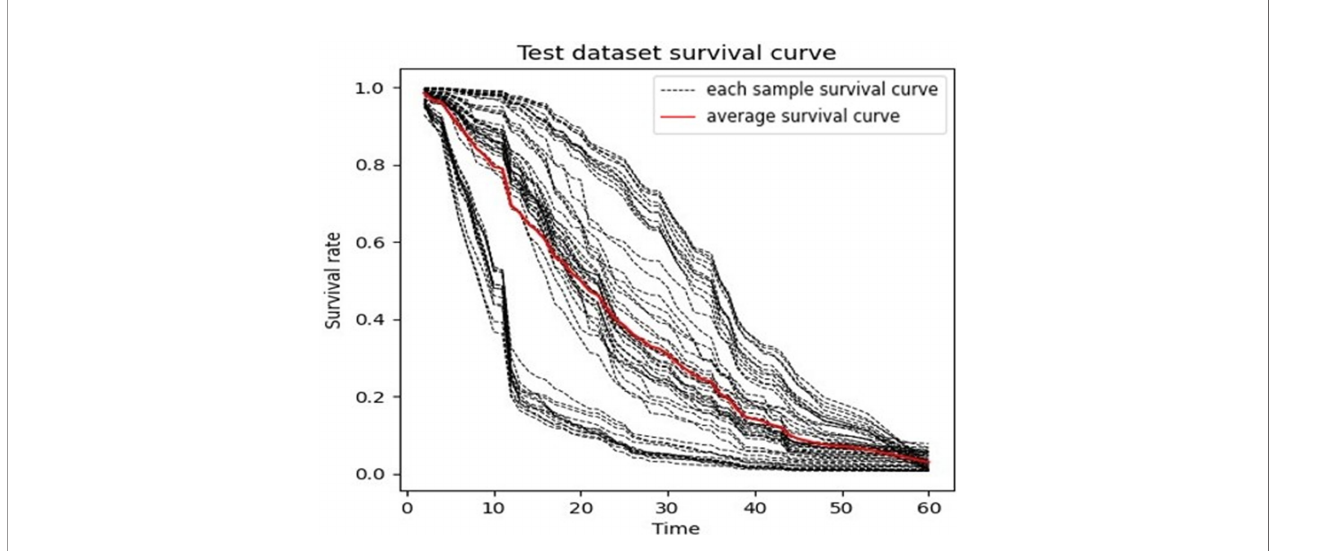
FIGURE 2 | Predicted Survival Curve (Random Survival